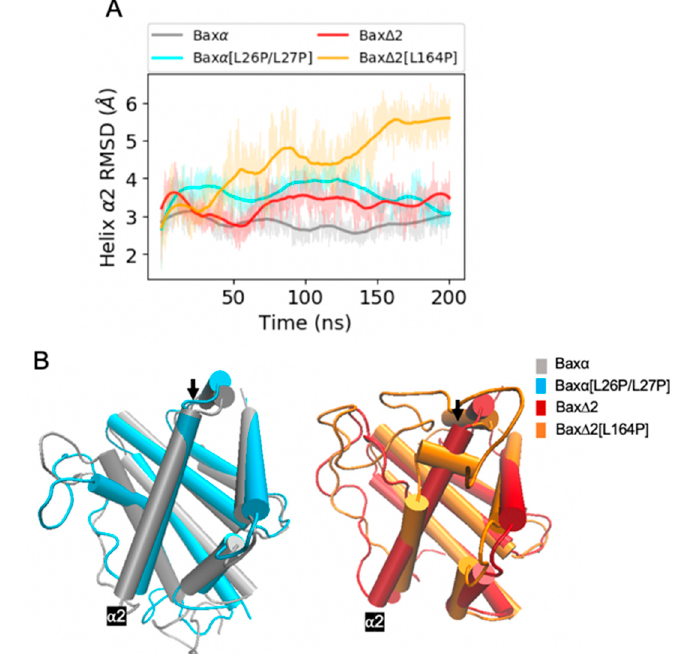
Figure 5. RMSD analysis of helix α 2. ( A ) RMSDs of Bax variant helix α 2 backbone atoms relative to the initial structure for a period of 200 ns of MD simulations. Shaded lines show RMSDs for all recorded points and solid lines are smoothed as described in Section 4.4. Similar plots for two additional repetitions of the simulations are shown in the bottom left panels of Figures S2 and S3. ( B ) Representative structures of Bax variants. The black arrow points at helix α 2.